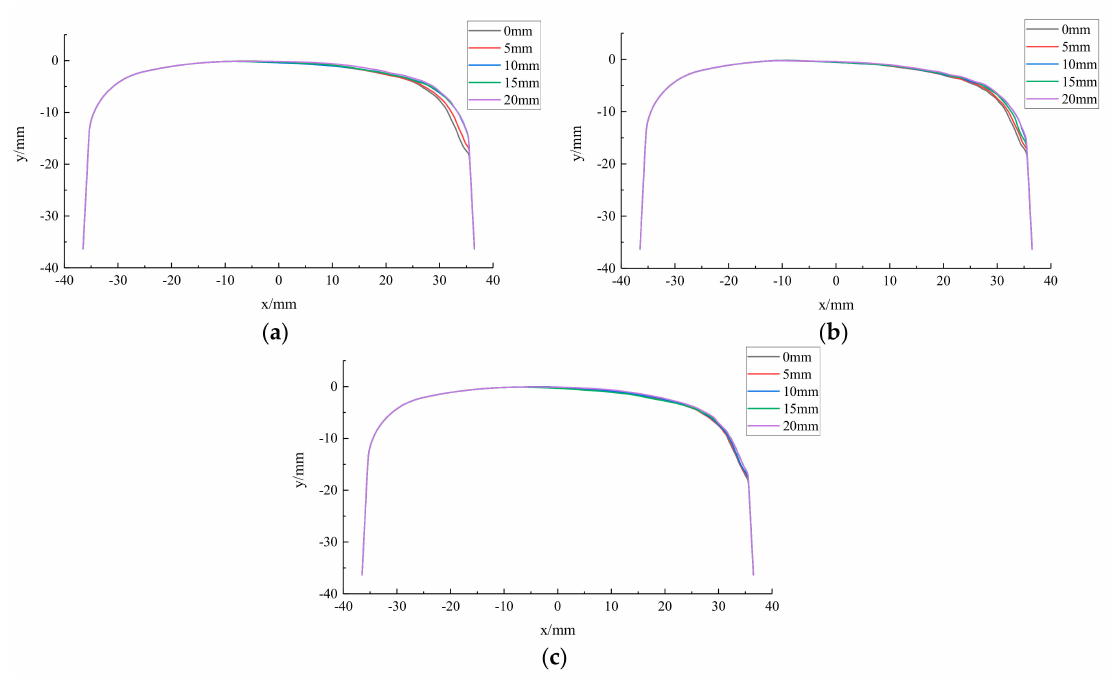
Figure 14. Evolution regularity of the rail profile. Radius: ( a ) 350 m; ( b ) 300 m; and ( c ) 250